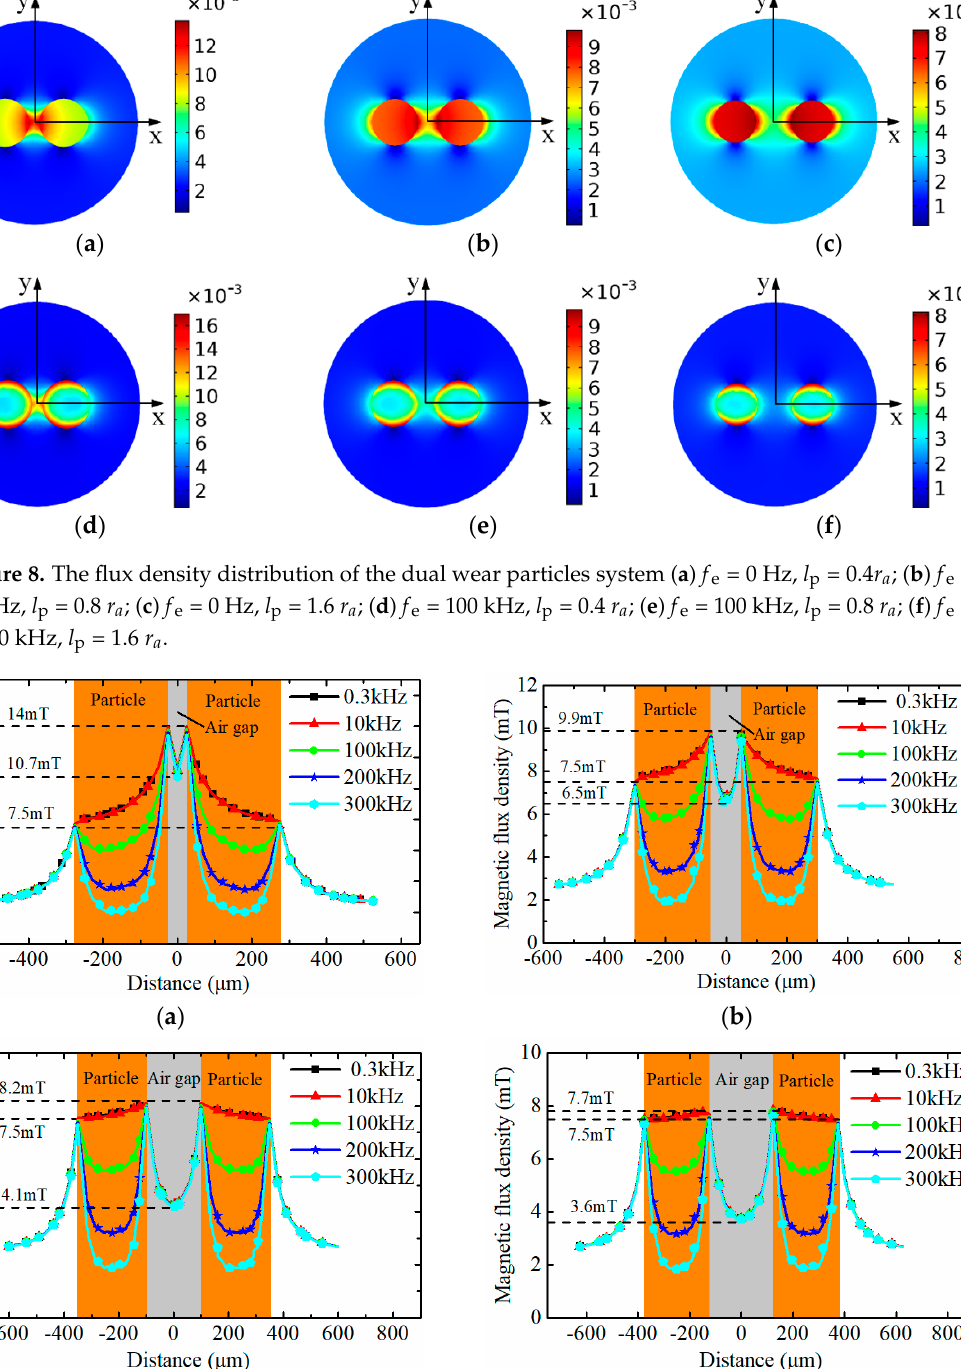
Figure 8. The flux density distribution of the dual wear particles system ( a ) f e = 0 Hz, l p = 0.4 r a ; ( b ) f e = 0 Hz, l p = 0.8 r a ; ( c ) f e = 0 Hz, l p = 1.6 r a ; ( d ) f e = 100 kHz, l p = 0.4 r a ; ( e ) f e = 100 kHz, l p = 0.8 r a ; ( f ) f e = 100 kHz, l p = 1.6 r a .